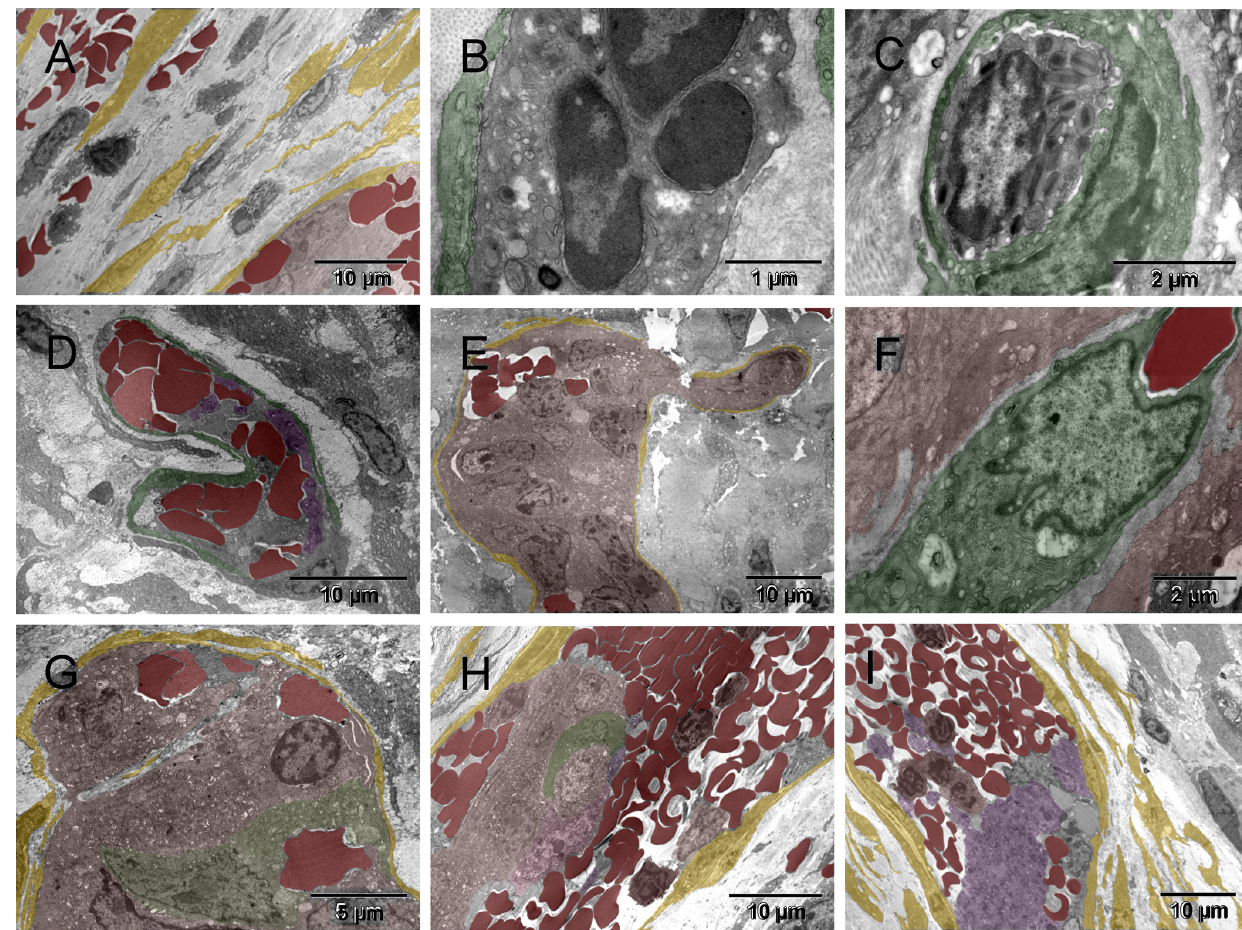
Figure S1. Delay in tumor vasculature development and capsular vaso-mimicry in the ectopic environment. Three weeks after implantation, the tumor environment consisted of single migrating cells that were secreting ECM components, mainly collagen (yellow), and others converting into erythrosomes (red) [ A ]. The erythroblast [ B ] and the eosinophil [ C ] were each in contact with a nucleated supporting cell on one side (green). A small primitive vessel, constituted mainly by erythrosomes (red) held together with megakaryocytes and platelets (purple), was located close to tumor (brown) [ D ]. It resembled those early ones seen in pseudo-orthotopic environment five days after implantation (Figure 2 in 41 ). Tumor cells were encapsulated by fibroblasts (yellow) and the cell population inside the capsules appeared heterogeneous [ E ]. There were erythrosomes (red) and nuclei of some cells had sinuses (green) [F & G] similar to those in ECs of a forming artery (Figure 8 in 41 ). Featured in [ H ] is a part of larger elongated capsule containing cluster of tumor cells (brown) in the center and multiple erythrosomes around it, all covered with typical flat, collagen producing fibroblasts, whereas a similar structure in [ I ] contained mainly erythrosomes and platelets (purple). Both were remarkably similar to a